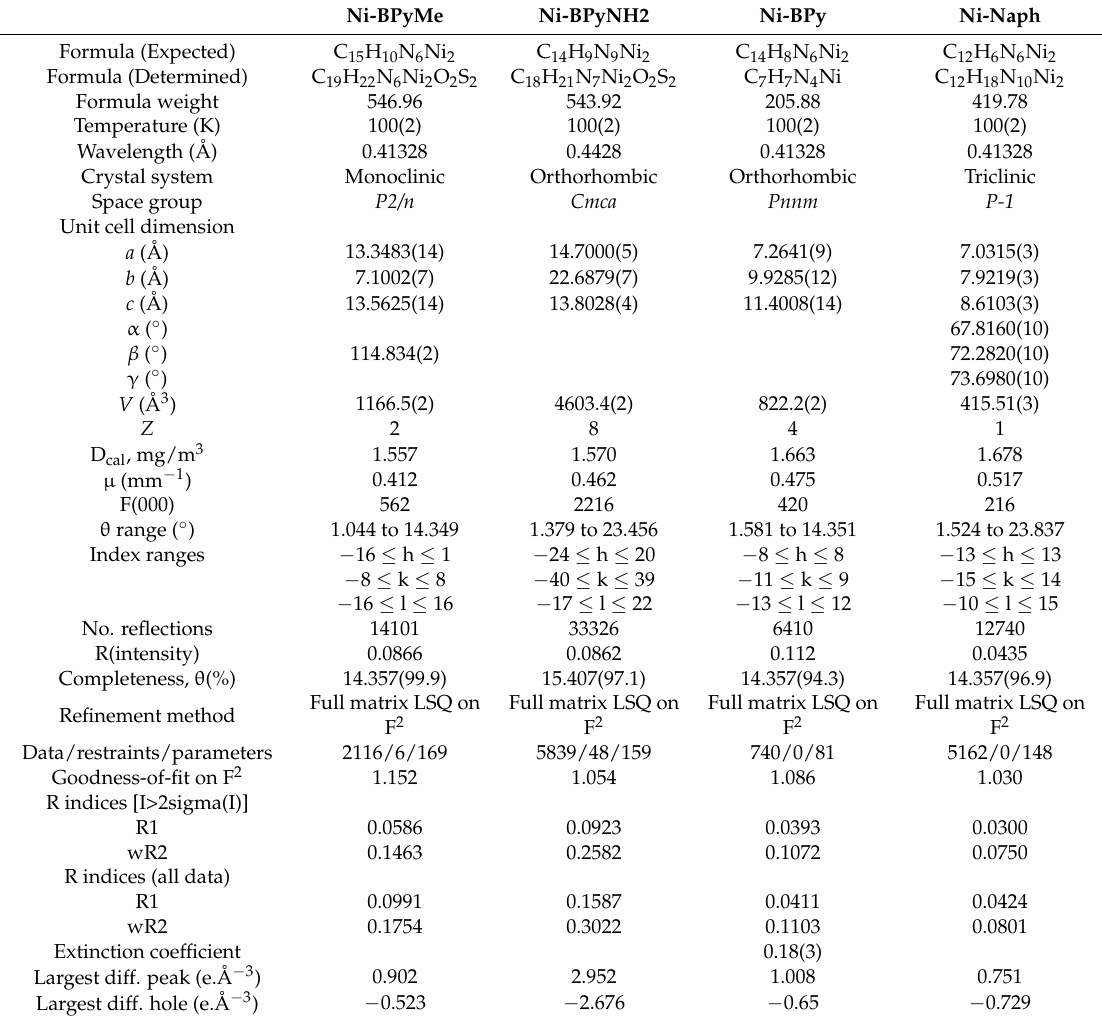
Table 1. Crystal Data and Structure Refinement for Four Cyanonickelate